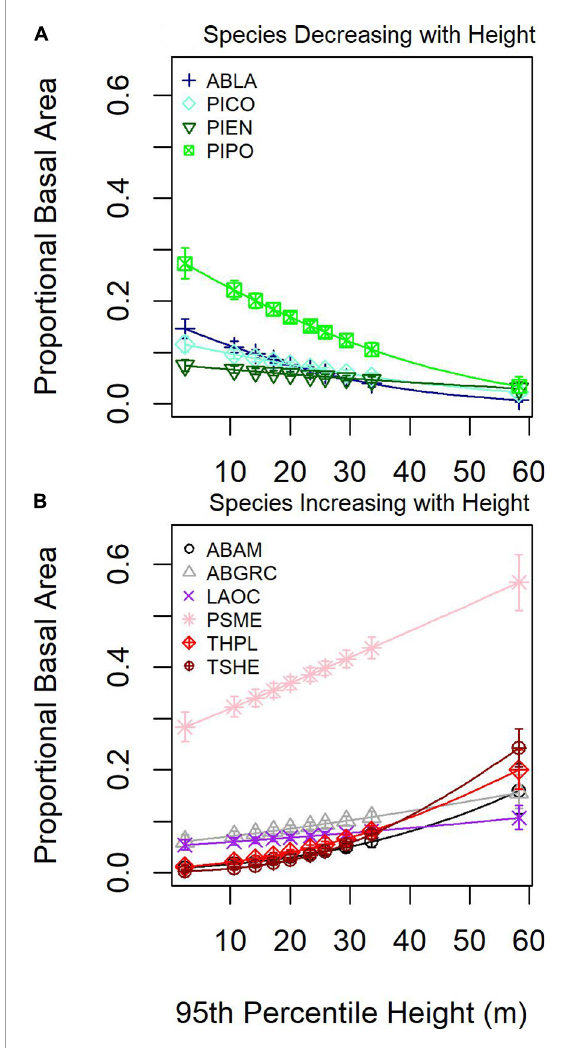
FIGURE7 Mean (line and symbols) and 95% confidence interval (whiskers) for proportional basal as a function of 80th percentile height from DAP for (A) four species showing an increasing response and (B) six species showing a decreasing